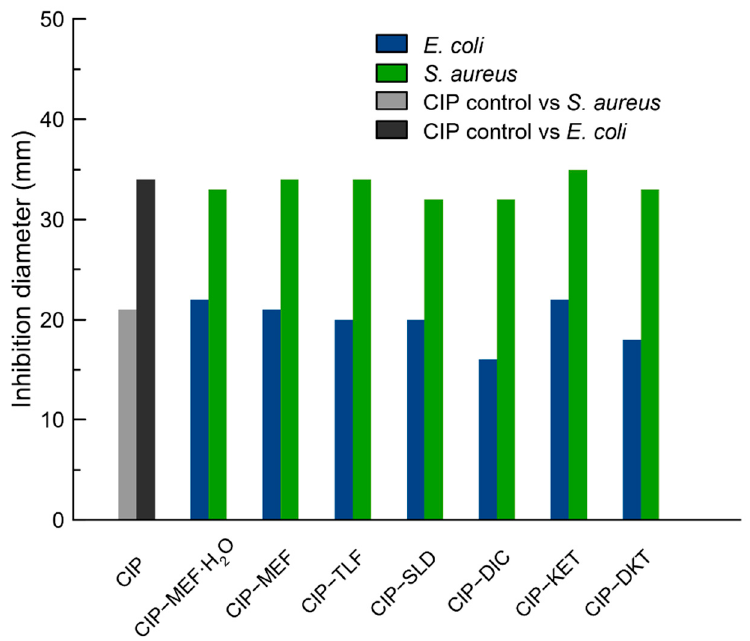
Figure 10. Antibiogram of CIP and the reported molecular salts tested against S. Aureus and E. Coli.